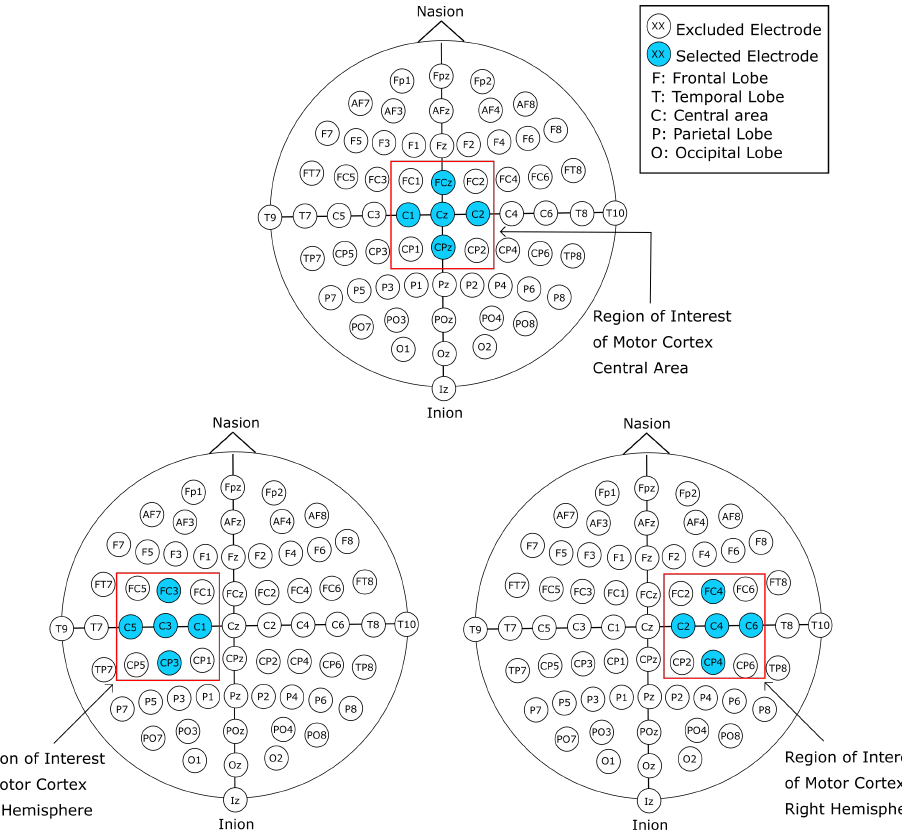
Figure 7. The 5-channel arrangement of electrodes selected for third variant vertically stacked spectrograms